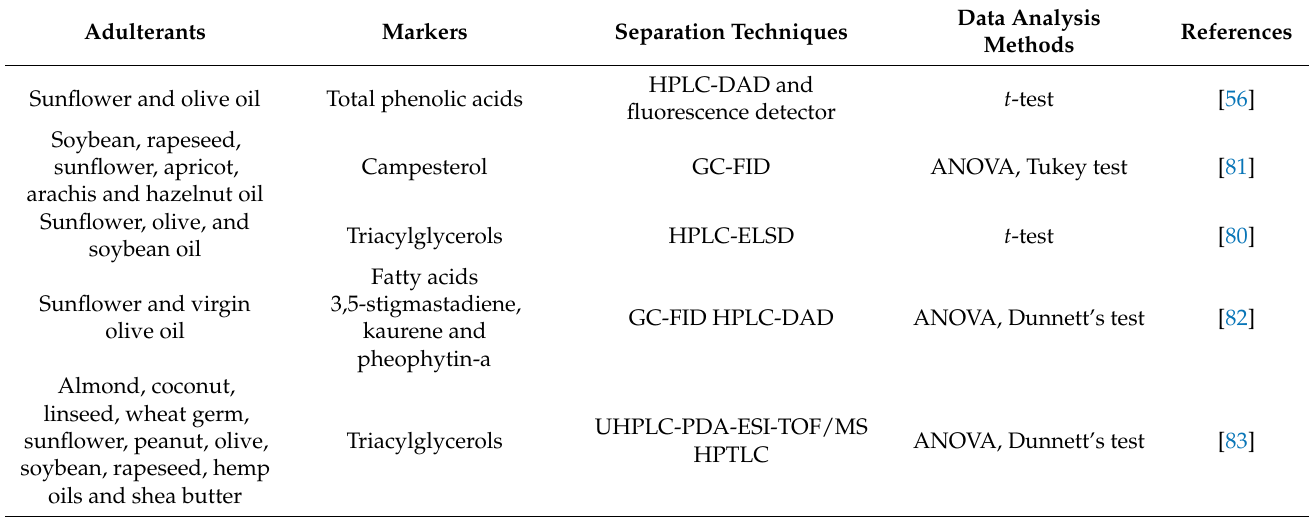
Table 5. Chromatographic techniques to detect adulteration in Argan oil: targeted